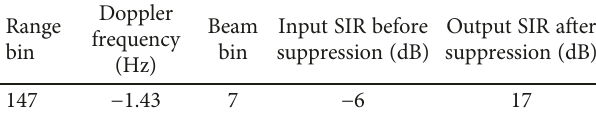
Table 1: Injected target